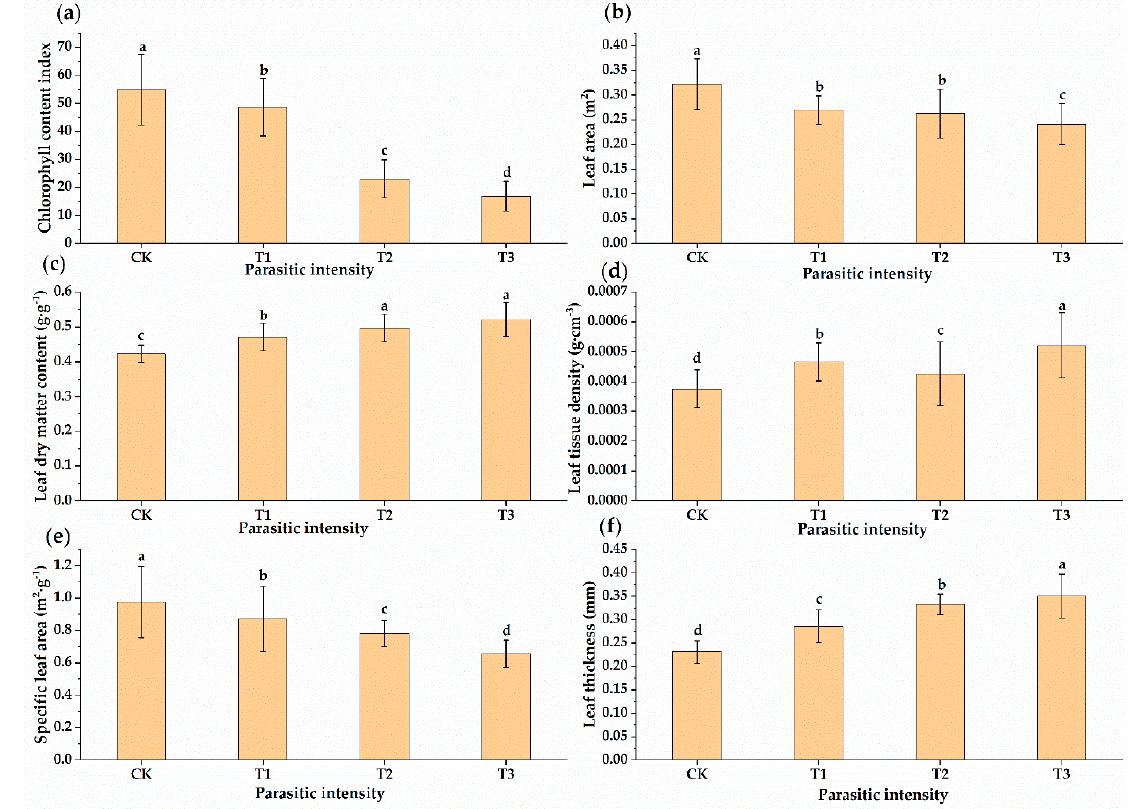
Figure 3. Changes in leaf functional traits under different parasitic intensities. Different lowercase letters indicate significant differences in parameters at the p < 0.05 level. ( a ) Chlorophyll content index, ( b ) leaf area, ( c ) leaf dry matter content, ( d ) leaf tissue density, ( e ) specific leaf area, ( f ) leaf thickness.